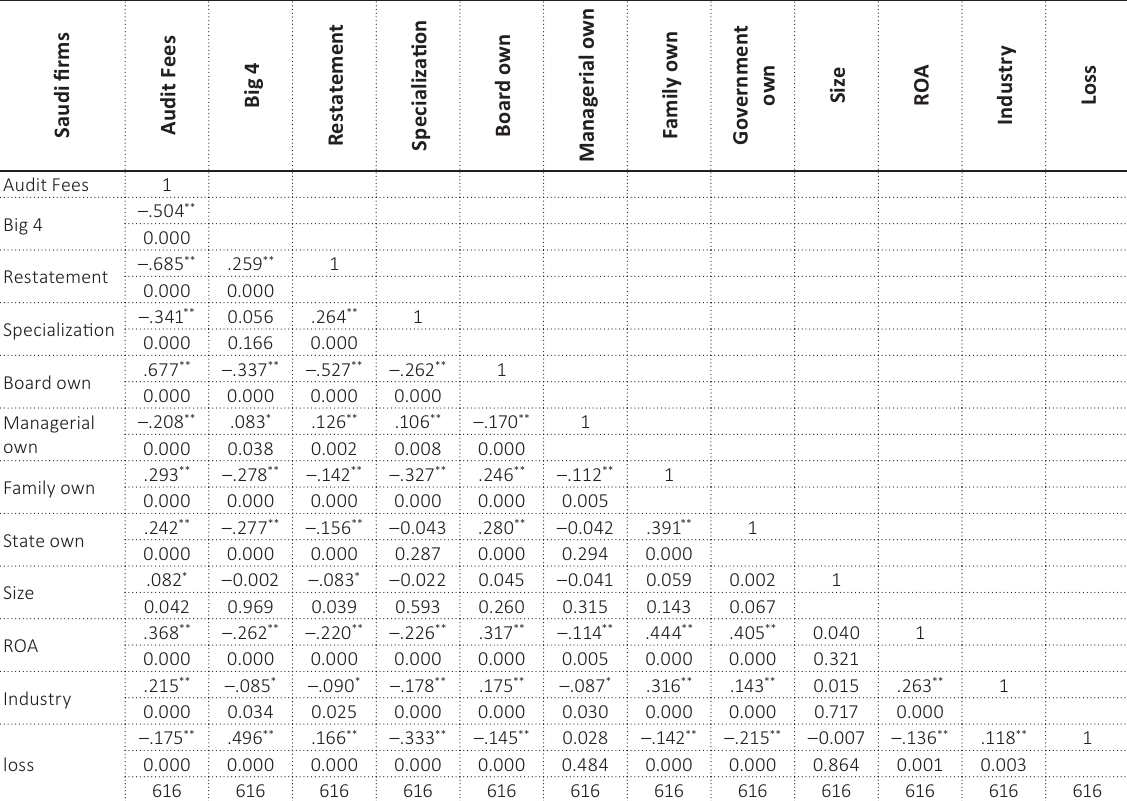
Table 4 (cont.). Correlation matrix